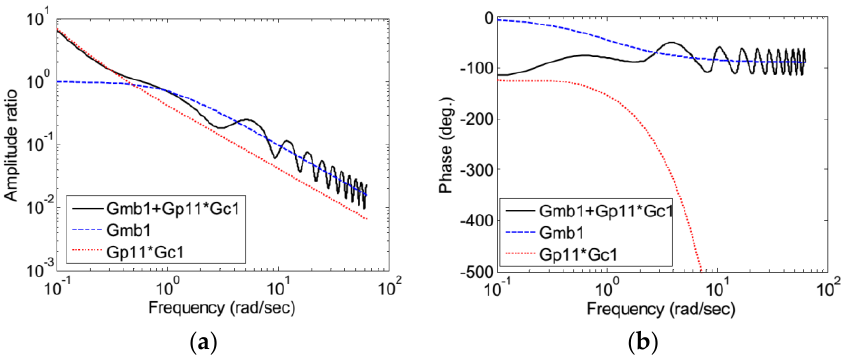
Figure 5. Frequency response of open-loop function for the first loop. ( a ) Amplitude Ratio ( b ) Phase